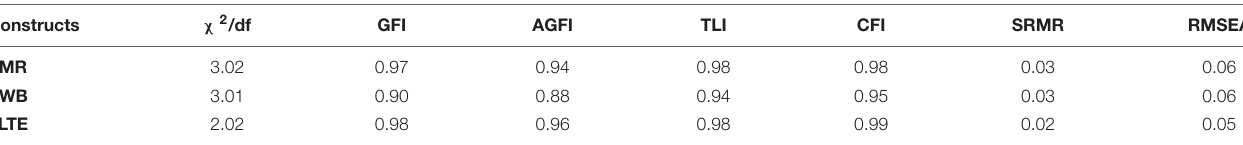
TABLE 3 | Goodness of fit measures for the research constructs. Constructs χ 2